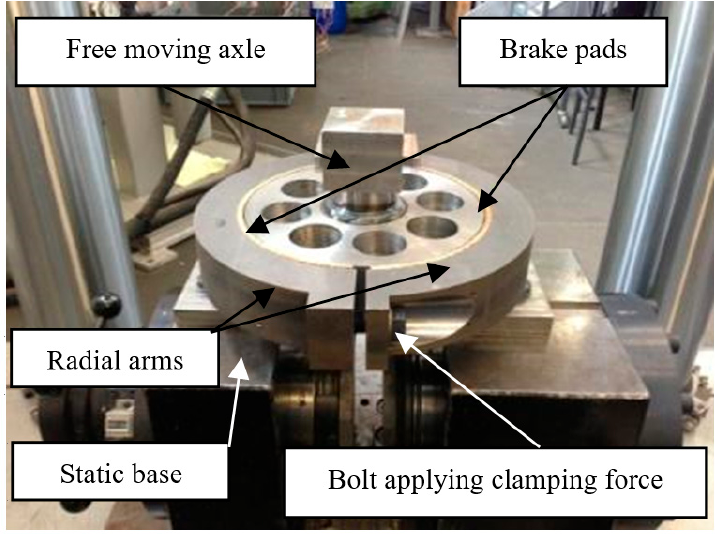
Figure 8. Testing platform.